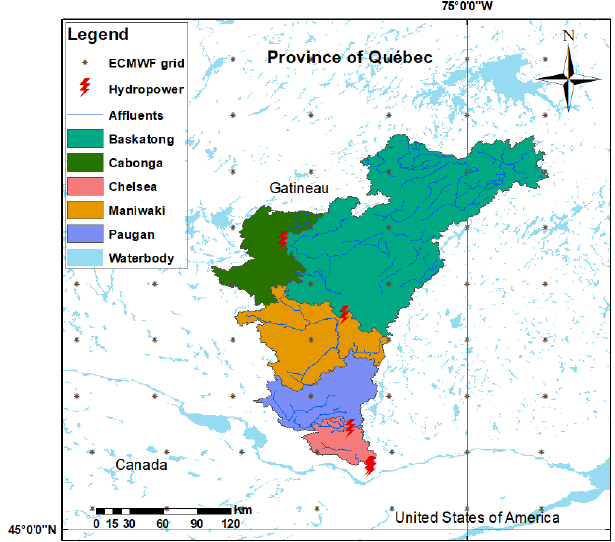
Figure 1. The five sub-catchments of the Gatineau River. The red thunder strike symbols locate the dams, while the original ECMWF grid points, before downscaling, are marked using black